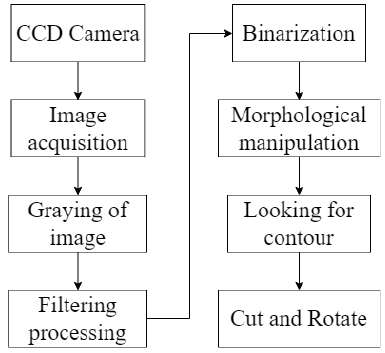
Figure 2. Target aluminum block extraction process.